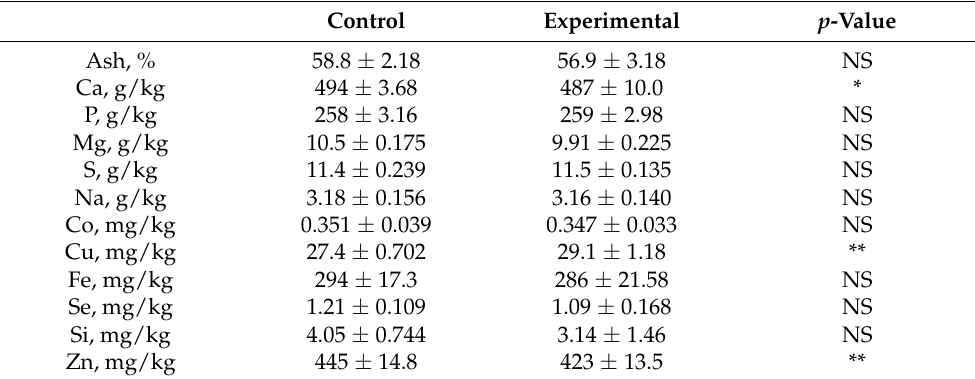
Table 4. The effect of infecting C. perfringens on the content of ash, macro-, and microelements in the bone tissue of the tibia in examined animals at the age of 42 days. Control Experimental p -Value Ash,